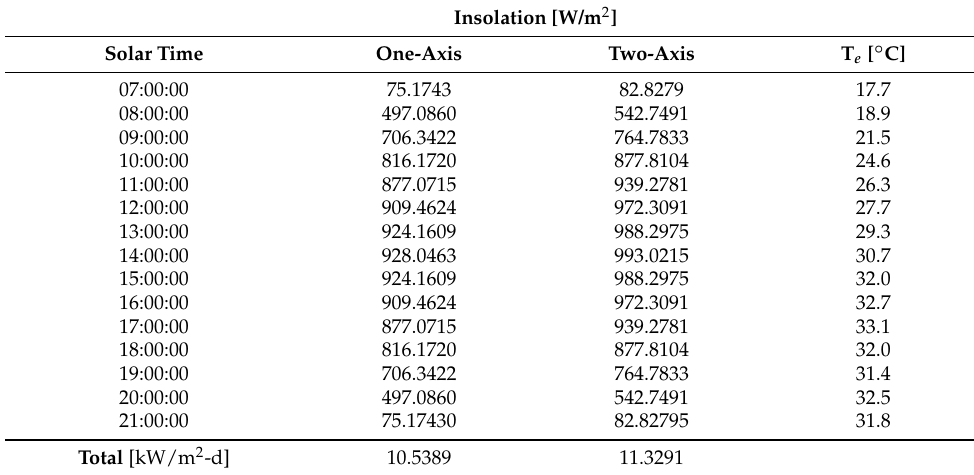
Figure 13. Hour-by-hour clear-sky insolation comparison between one-axis polar mount tracker and a two-axis tracker. Table 9. Hour-by-hour clear-sky insolation and environment temperature T e in 20 June 2018, for Madrid,